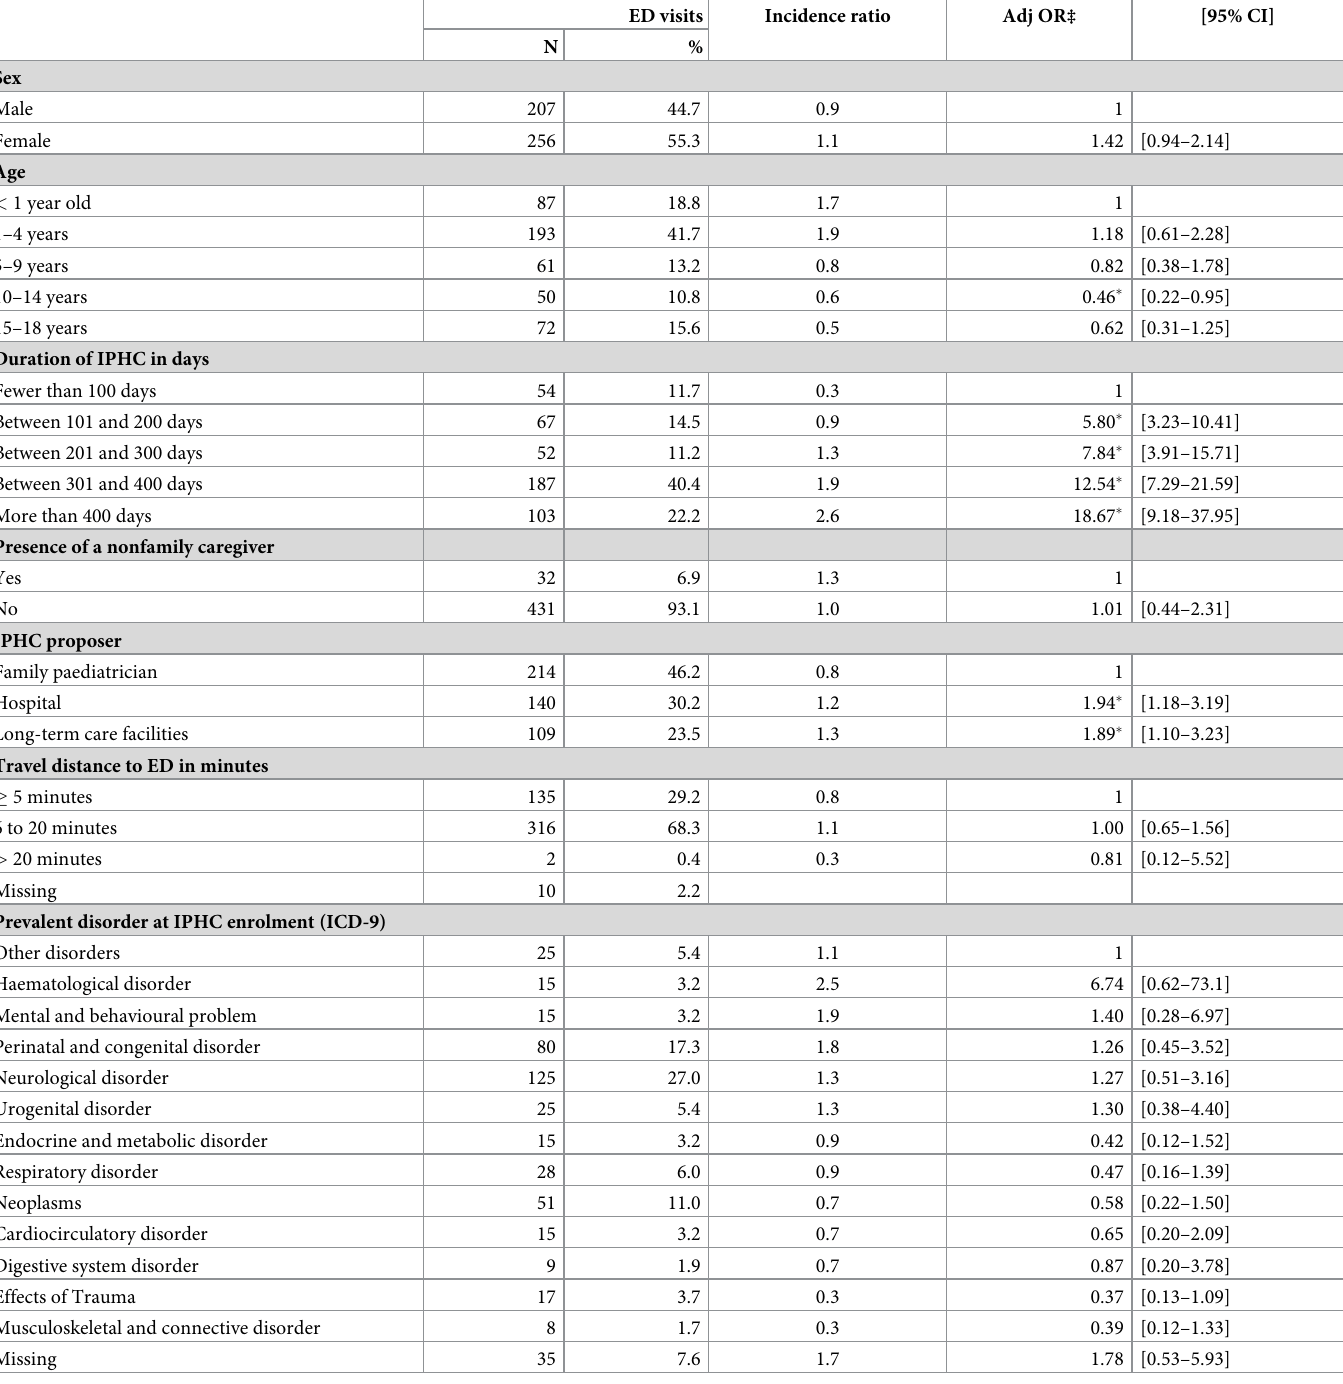
Table 3. ED visits (N = 463), incidence ratio, adjusted odds ratios (ORs) and 95% confidence intervals (95% CIs) predicted ED use among patients enrolled in the IPHC program between 2012 and 2017.